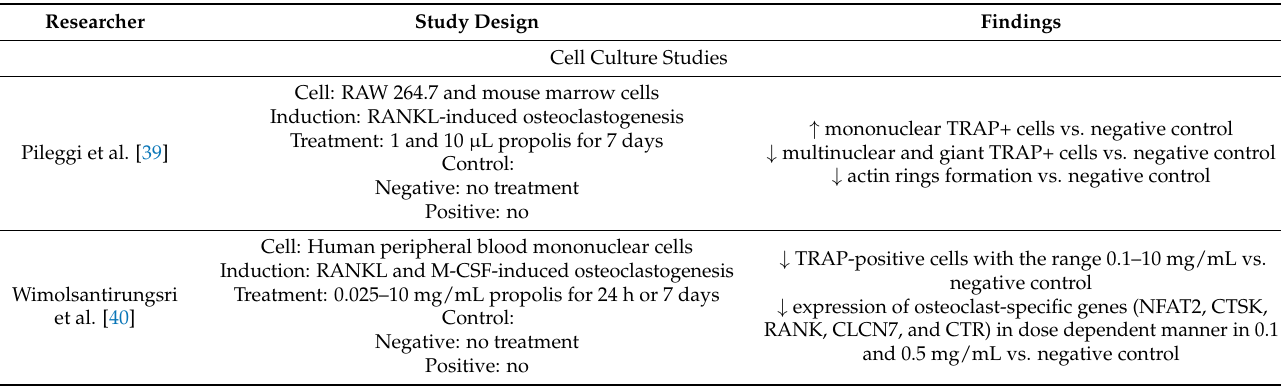
Table 1. Proof of propolis for protection of bone